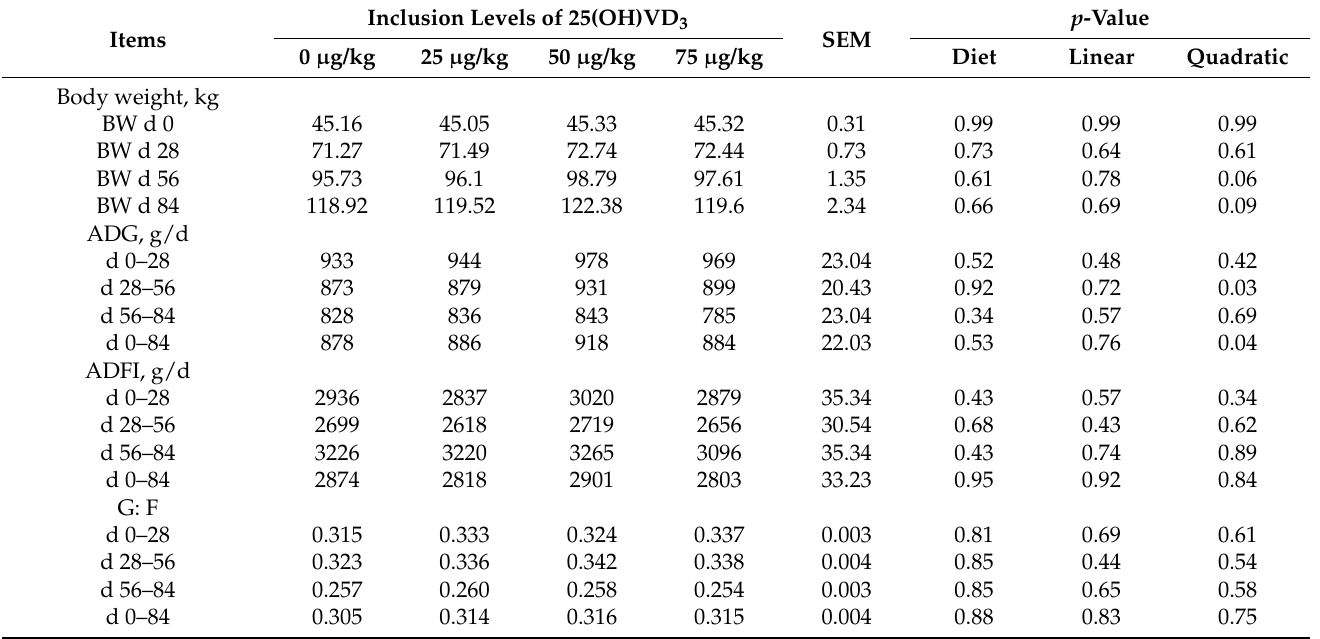
Table 2. Effects of 25(OH)VD 3 inclusion doses on growth performance of growing-finishing pigs.